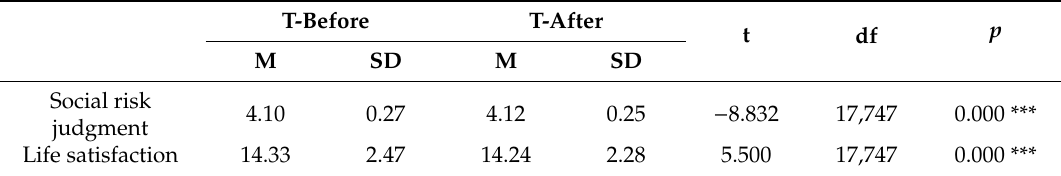
Table 4. Cognitive indicators before and after 20